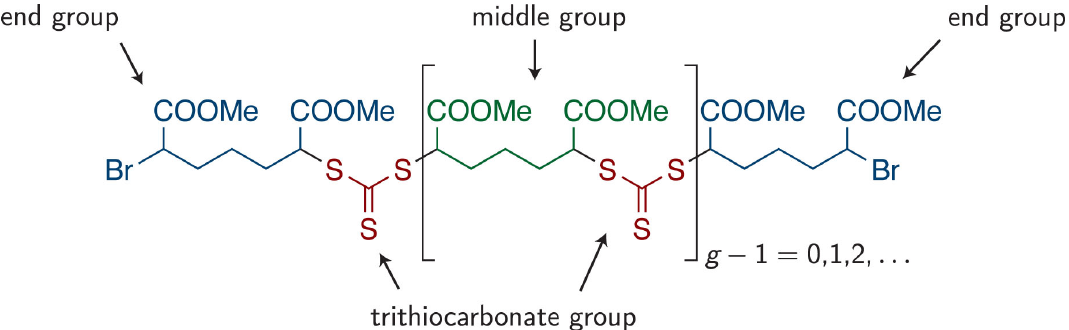
Figure 1. General structure of the employed RAFT